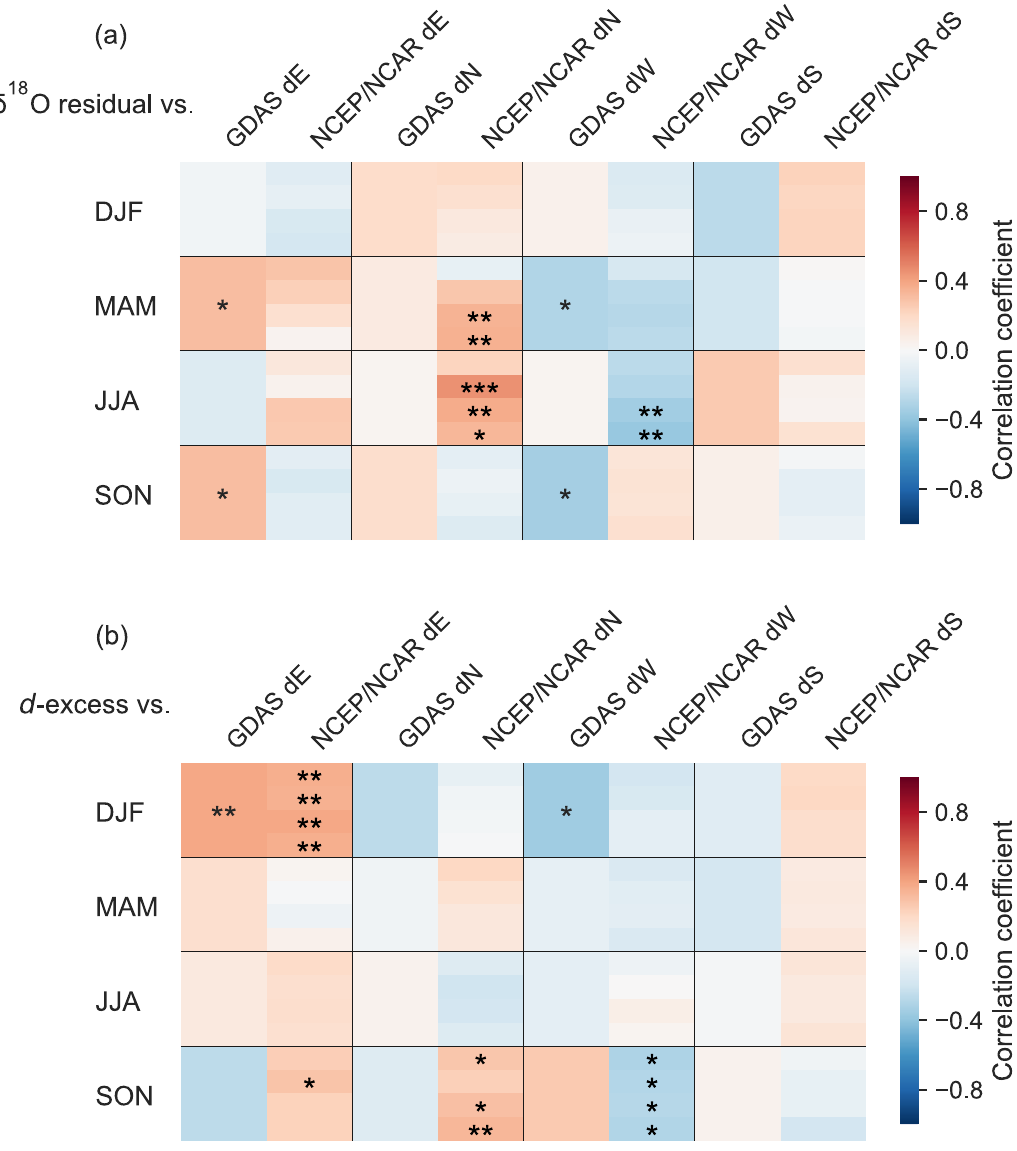
Figure 5. The seasonal correlation coe ffi cient heat map for monthly proportions of precipitation derived from di ff erent trajectory clusters (dE, dN, dW, and dS) with ( a ) monthly δ 18 O e p and with ( b ) monthly d -excess. For the NCEP / NCAR reanalysis dataset, the grid is segmented into four parts that from top to bottom represent the result with an initial back-trajectory height of 500 m, 1000 m, 1500 m, and 2000 m, respectively. Significance levels are noted by the following: * p < 0.1, ** p < 0.05, *** p < 0.01. The numbers of data for correlation analysis are listed in Table